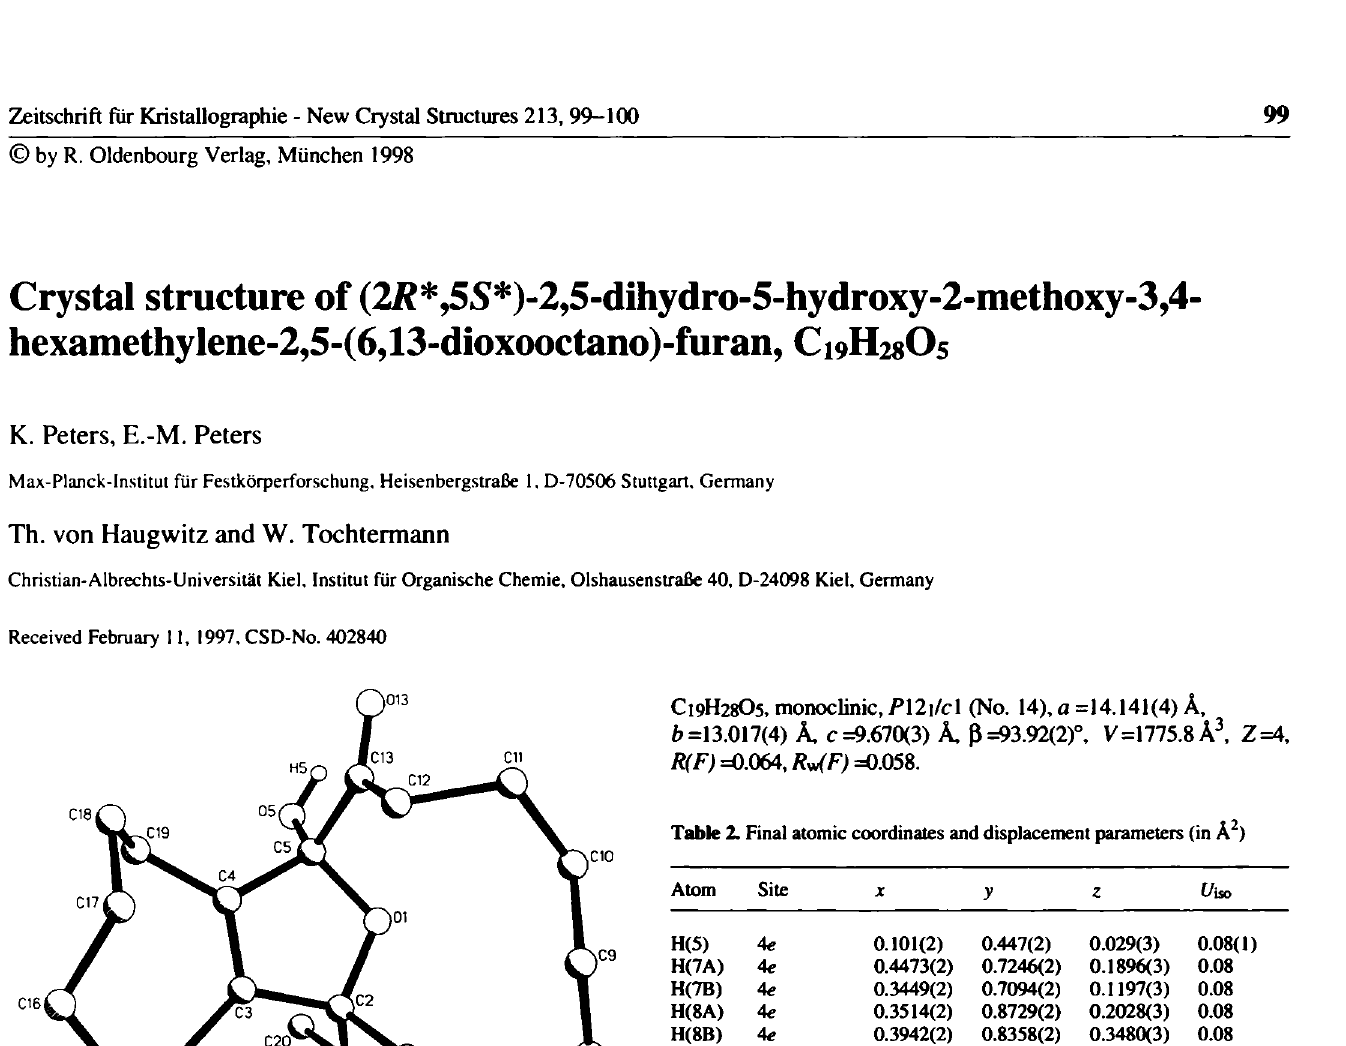
Table 1. Parameters used for the X-ray data collection